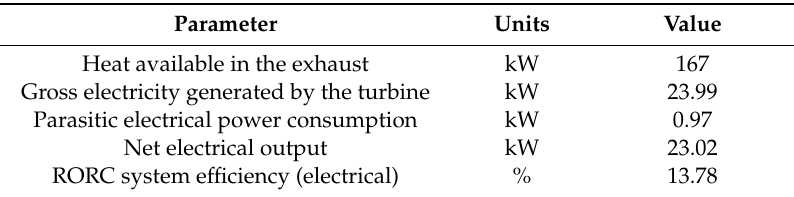
Table 11. Results of the RORC Aspen Plus